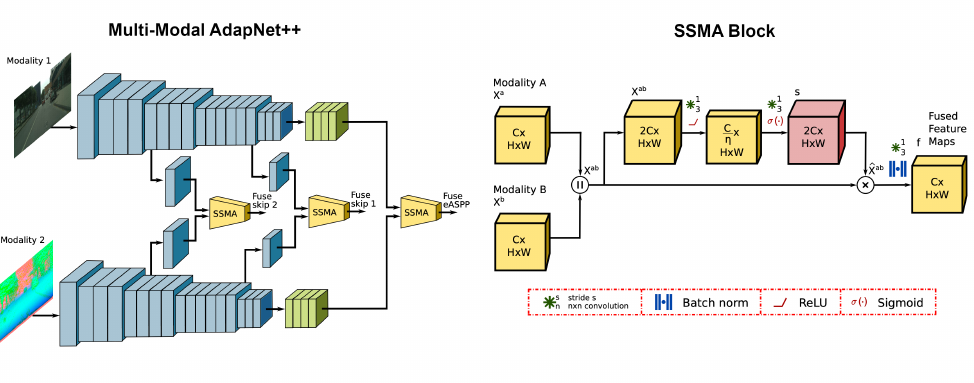
Figure 6. Figure from [98] that explains the work’s multimodal semantic segmentation scheme. Reprinted with permission from the authors of [98]. Copyright 2019, Springer Nature Switzerland